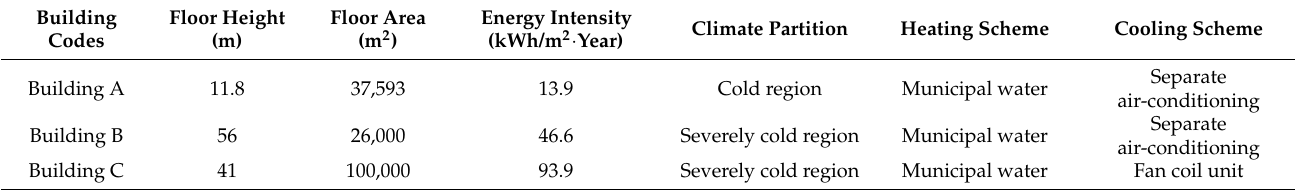
Table 1. Basic information for Buildings A, B, and C.